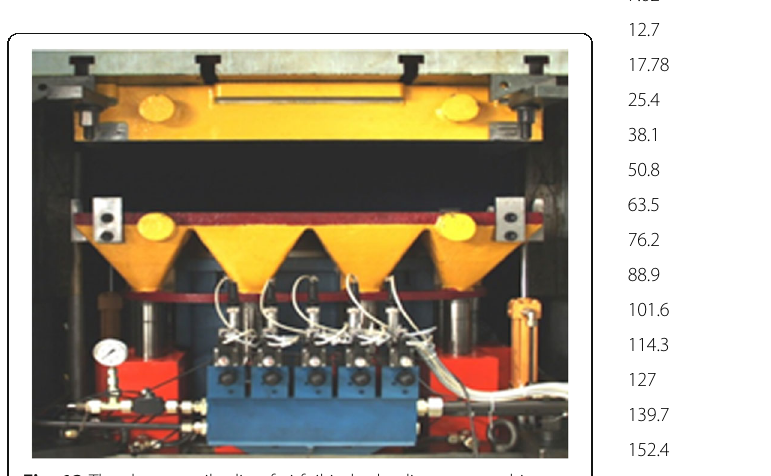
Fig. 12 The deep tensile die of airfoil in hydraulic press machine